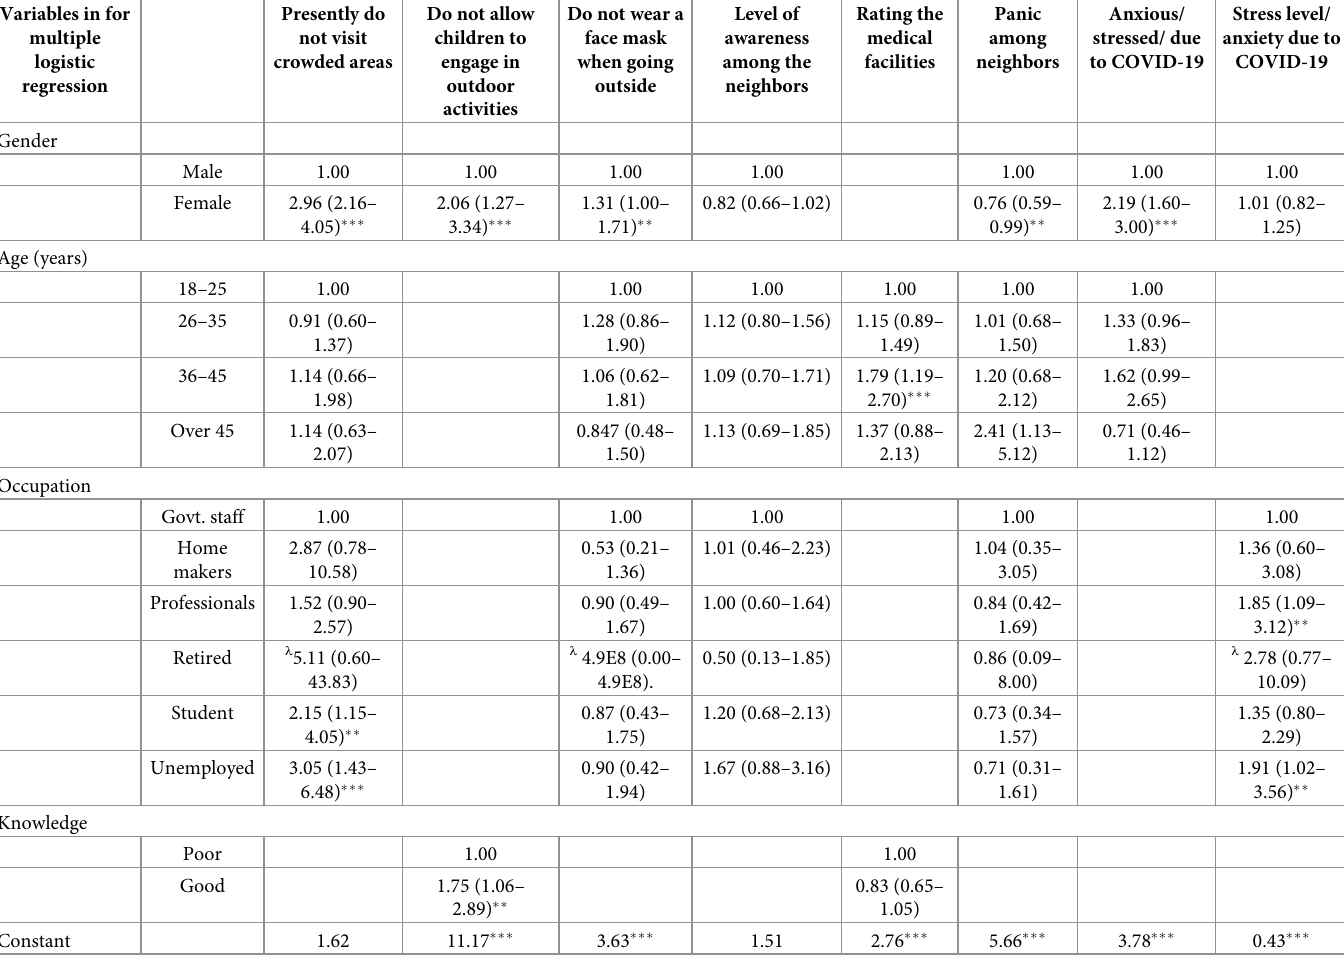
Table 8. Multiple logistic regressions of different variables of practices with socio-demographic variable and knowledge status. (Values are odds ratio followed by 95% confidence interval in parenthesis). Variables in for multiple logistic